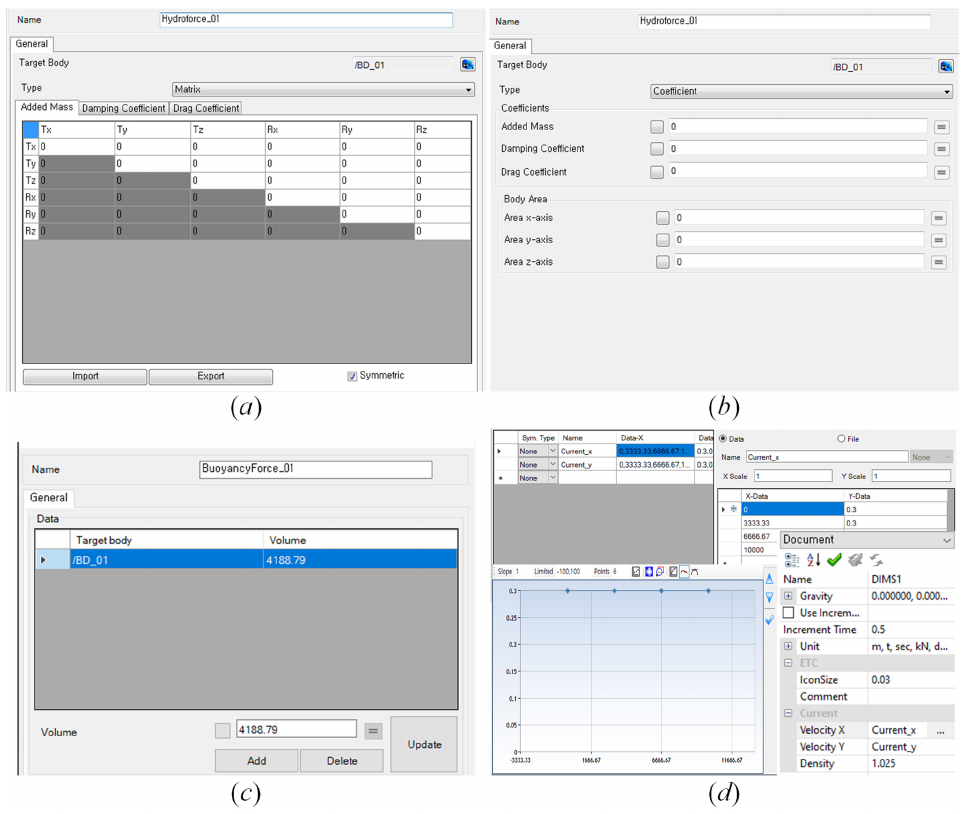
Figure 21. User interface of environment modeler: ( a ) matrix input dialog for hydrodynamics, ( b ) constant input dialog for hydrodynamics, ( c ) input dialog for buoyancy, ( d ) input dialog for ocean current.